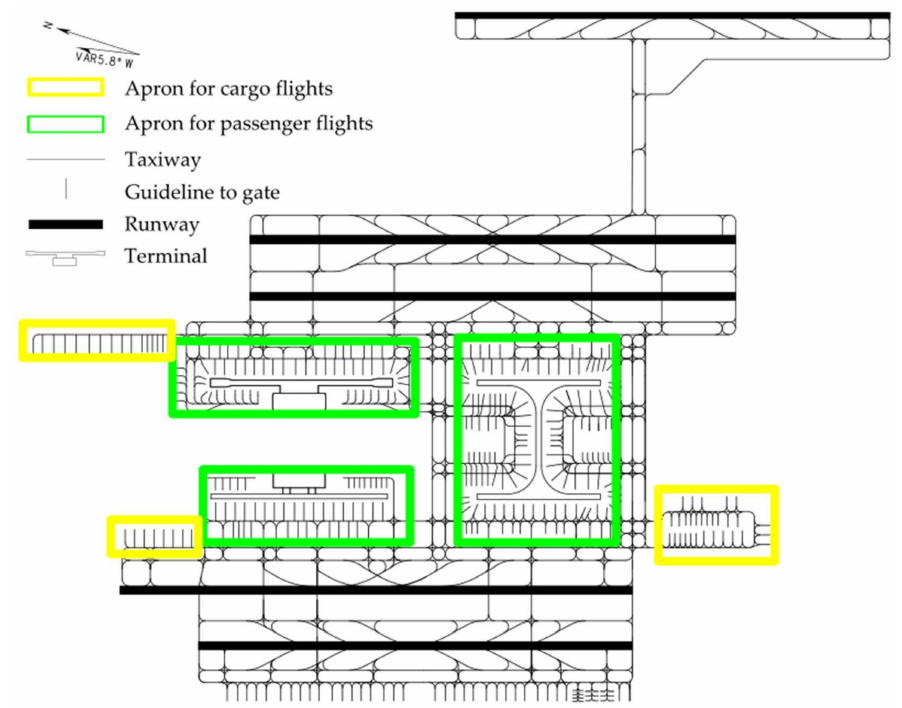
Figure 1. Network of Pudong